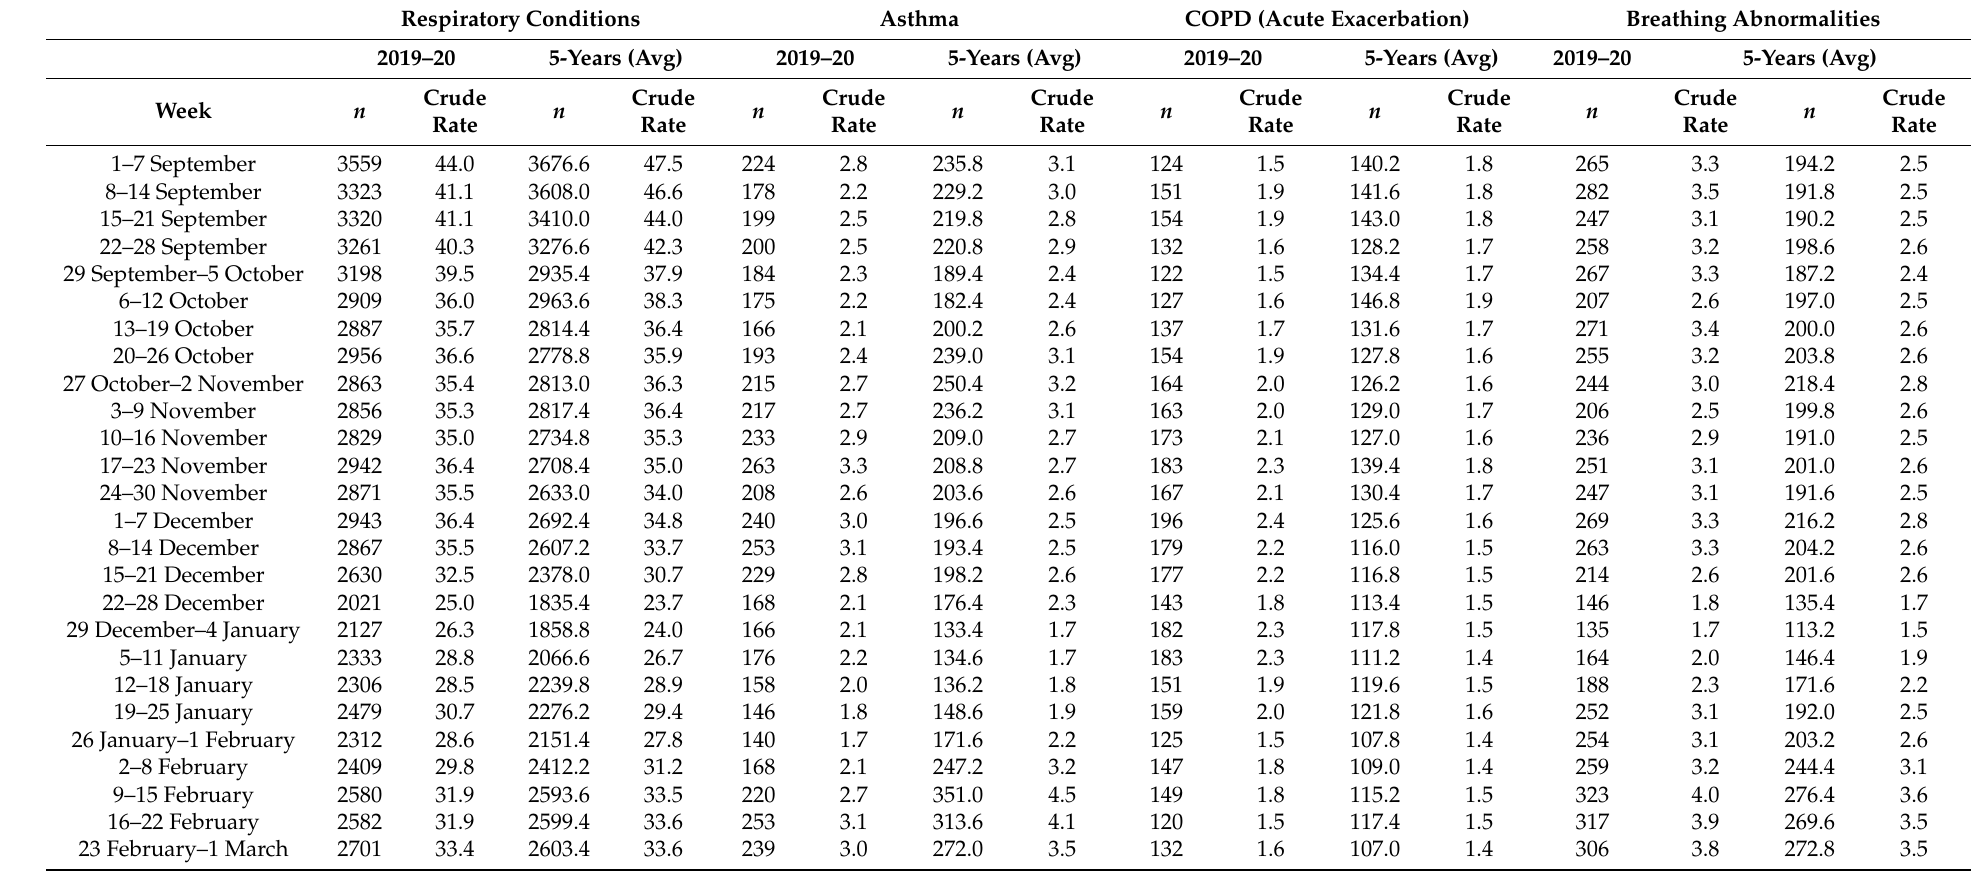
Table 3. Number and crude rate of admitted patient hospitalisations during the 2019–2020 bushfire season and previous 5-years